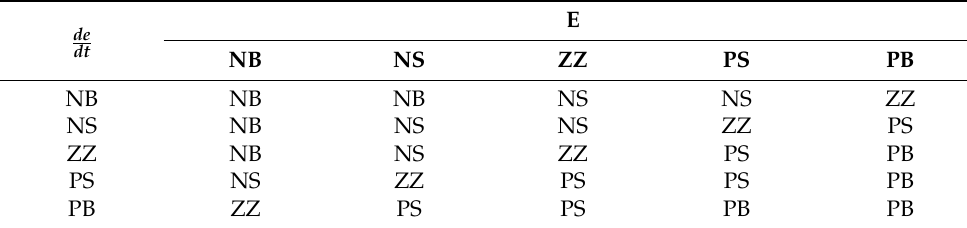
( e ) MFs for output — 5 Figure 7. Output MFs of fuzzy system.